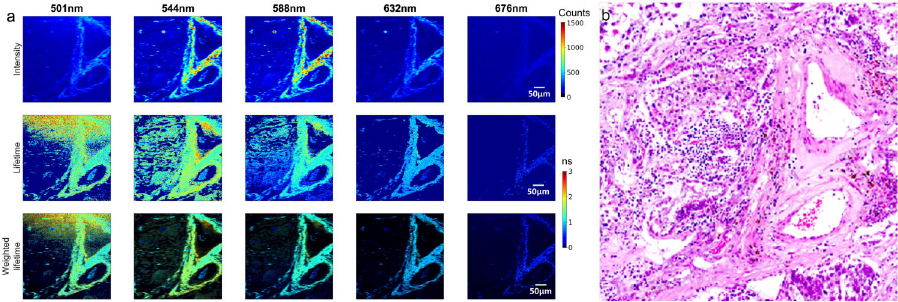
Fig. 1 False-colour FS-FLIM images of 256 × 256 pixels, with a fi eld of view (FOV) of 600 × 600 µ m, at fi ve different wavelengths. a FLIM images at various emission wavelengths. The fi rst row presents intensity images, the second row is the corresponding lifetime images, and the third row is the intensity-weighted lifetime images. b A manually cropped histology patch with a larger FOV than the FS-FLIM